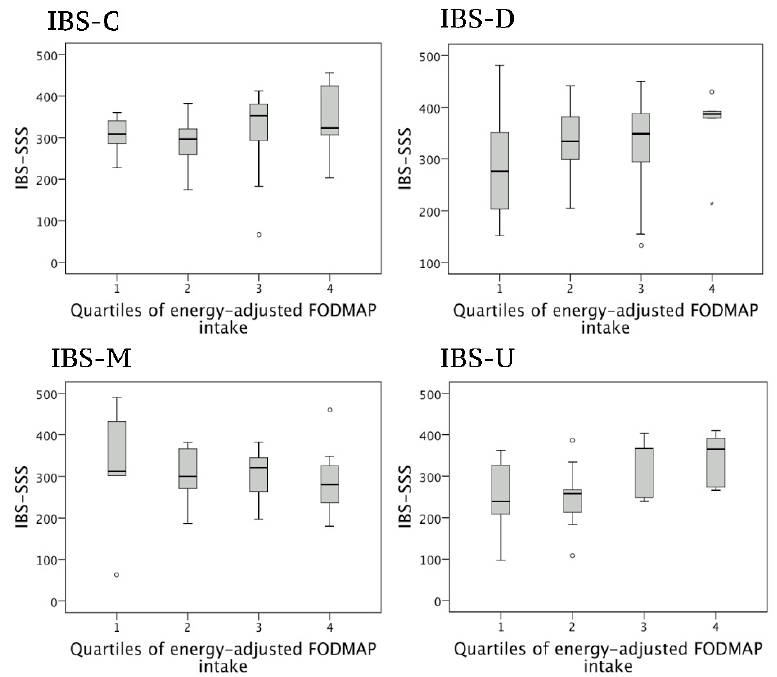
Figure 1. Boxplots are showing the relationship between quartiles of energy-adjusted intake of FODMAPs and IBS symptom severity among women within different subtypes of IBS. Box plots shows median values (solid horizontal line) 50th percentile values (box outline), 90th percentile values (whiskers), outlier values (circles) and extreme outliers (asterisks). Abbreviation: FODMAP, fermentable oligo-, di-, monosaccharides and polyols; IBS, irritable bowel syndrome; IBS-C, IBS with constipation, IBS-D, IBS with diarrhea, IBS-M, mixed IBS, IBS-U, unsubtyped IBS; IBS-SSS, IBS severity scoring